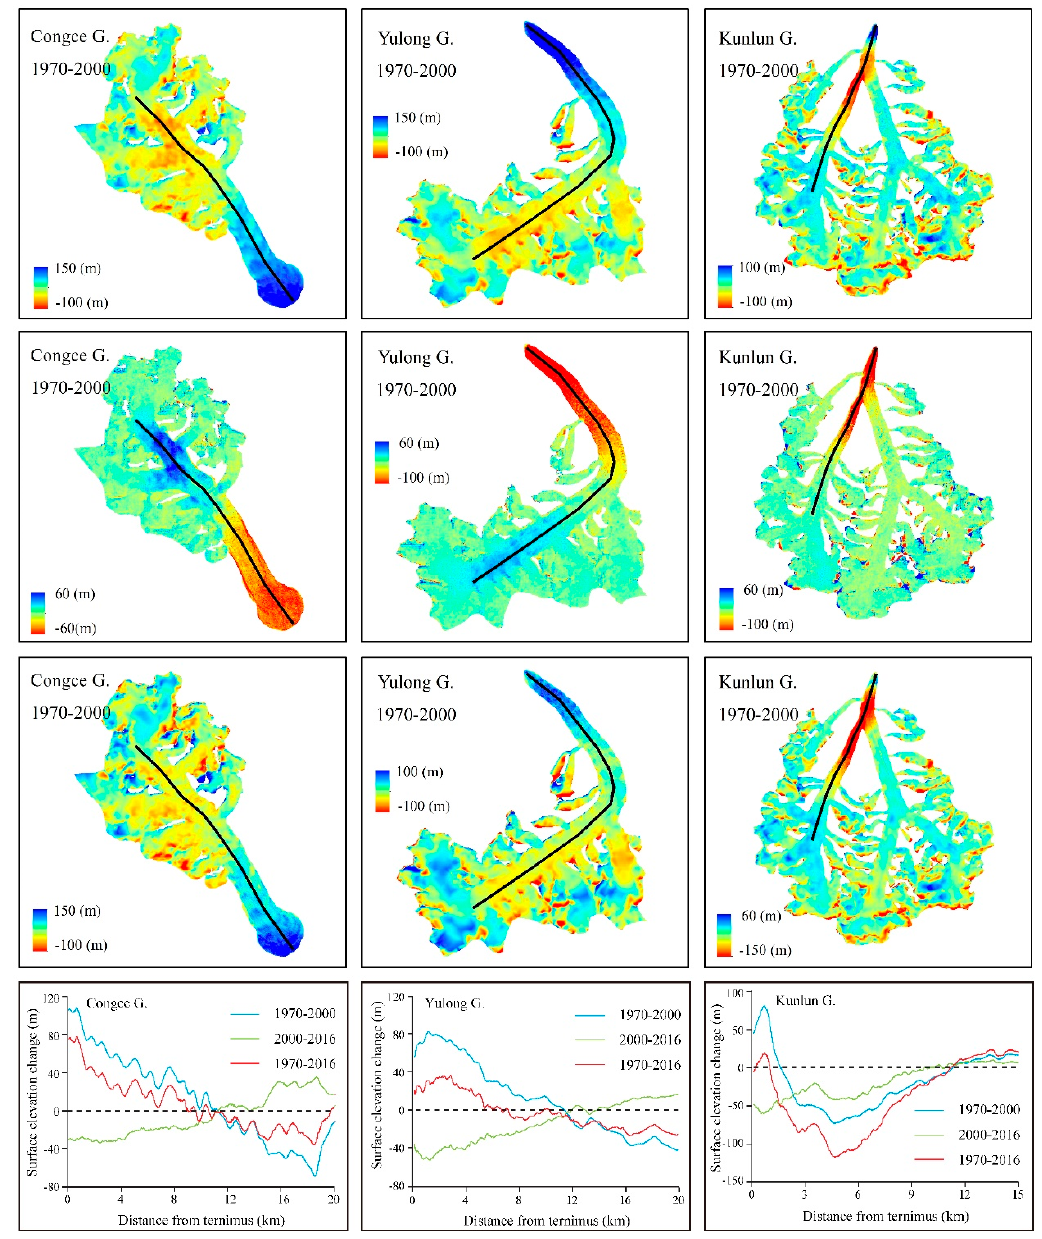
Figure 7. Changes in glacier surface elevation over time periods and their changes along the longitudinal section in Congce G., Yulong G. and Kunlun G. The locations of glaciers are shown in Figure 4 in green font.